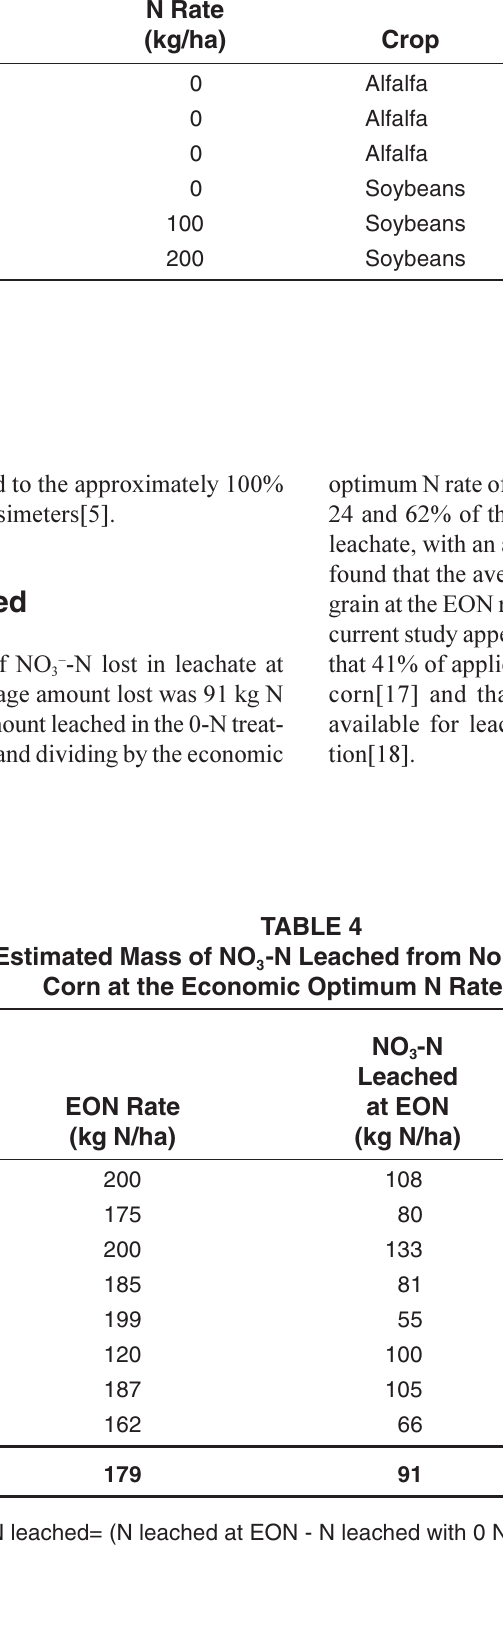
Average NO -N Concentrations Leaching from Legumes 3 Prev. Corn